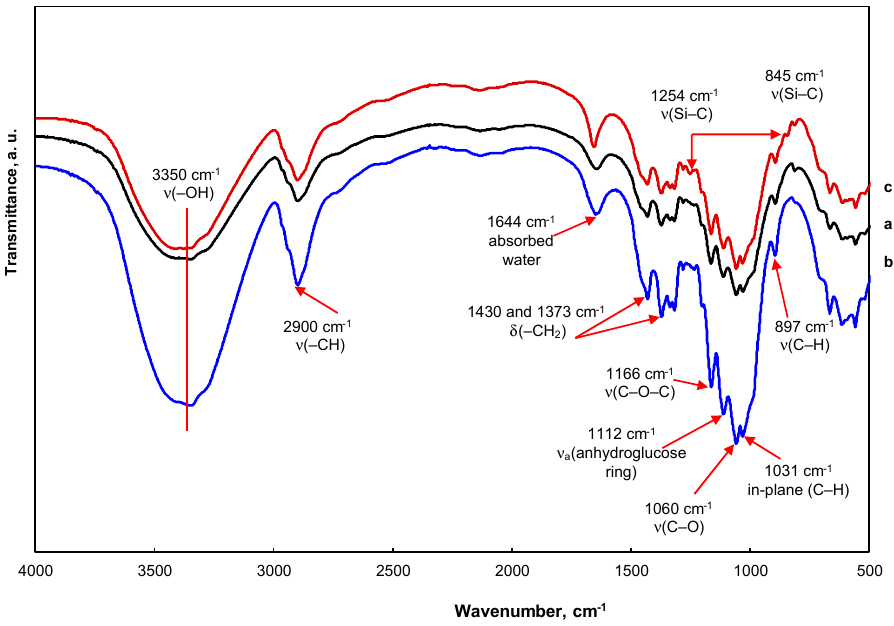
Figure 4. FTIR spectra of ( a ) CF, ( b ) CFliq, and ( c ) CFvap.